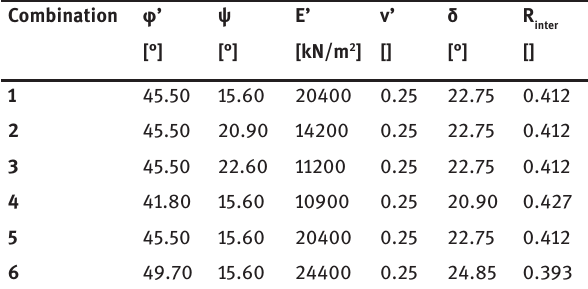
Table 6: Geotechnical parameters used in the analyses (Case b) Combination φ’